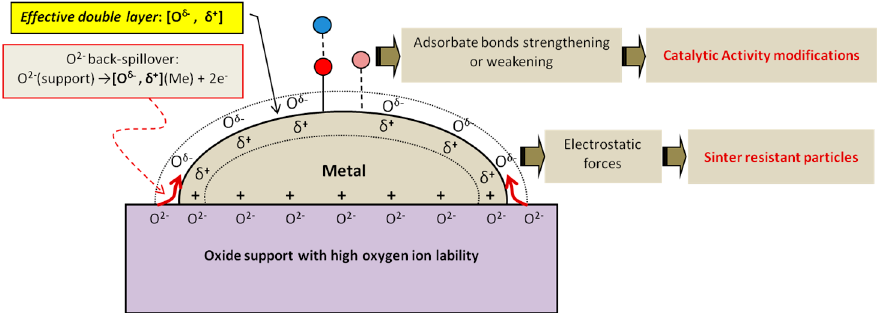
Figure 7. The mechanism of formation of the e ff ective double layer [O δ − , δ + ] and its roles in surface catalytic phenomena and inhibition of metal sintering.